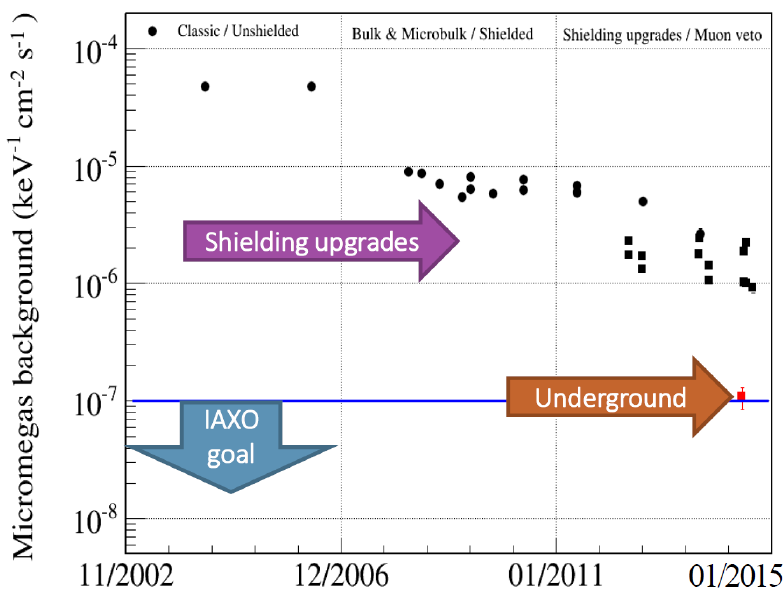
Figure 18. Evolution of the Micromegas background levels in different periods of the CAST data taking. The last point on the right represents the background level obtained in LSC under special shielding conditions. The background level targeted for BabyIAXO is at least 10 − 7 c/keV/cm 2 /s.